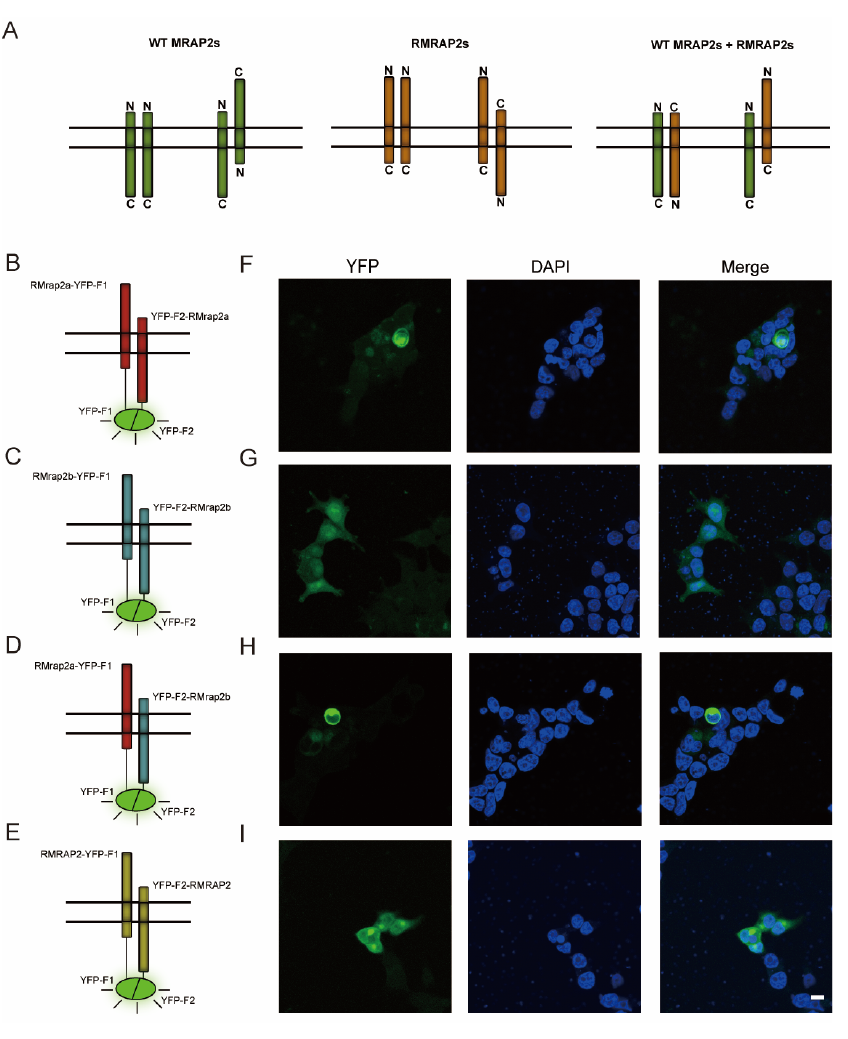
Figure 3. RMrap2a/b and RMRAP2 form antiparallel dimers on the plasma membrane. ( A ) Schematic illustration of parallel and antiparallel dimers of WT MRAP2s ( left ), RMRAP2s ( middle ) as well as WT MRAP2 and RMRAP2 dimers ( right ). ( B – E ) The schematic diagrams illustrate the principle of YFP fluorescence emission and the localization of YFP ‐ F1/F2 on the fused protein. Red: RMrap2a, blue: RMrap2b, yellow: RMRAP2. ( F – I ) YFP fluorescent and DAPI under confocal microscope. Scale bar = 10 μ m.